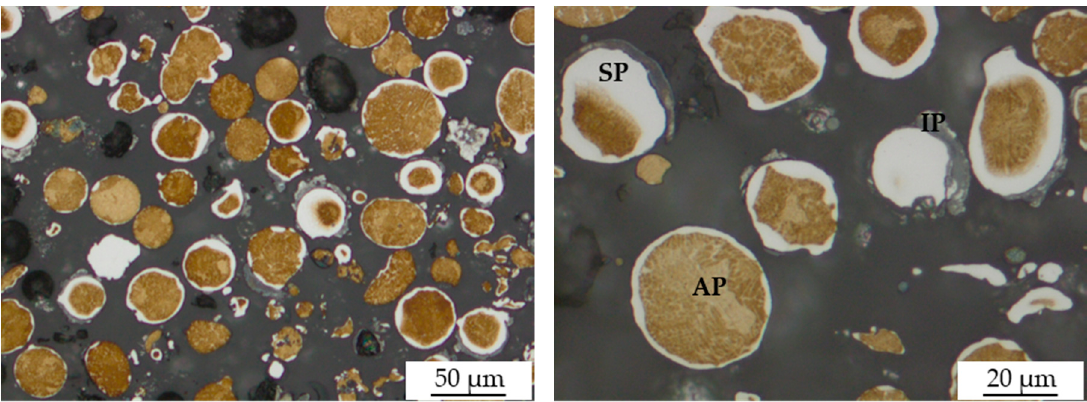
Figure 2. Optical-microscopic images of Beraha-II etched AISI 316L powder feedstock after gas nitrocarburization with low magnification ( left ) and detail view ( right ) with phase declaration (SP—S-phase; AP—austenitic phase; IP—impurity).